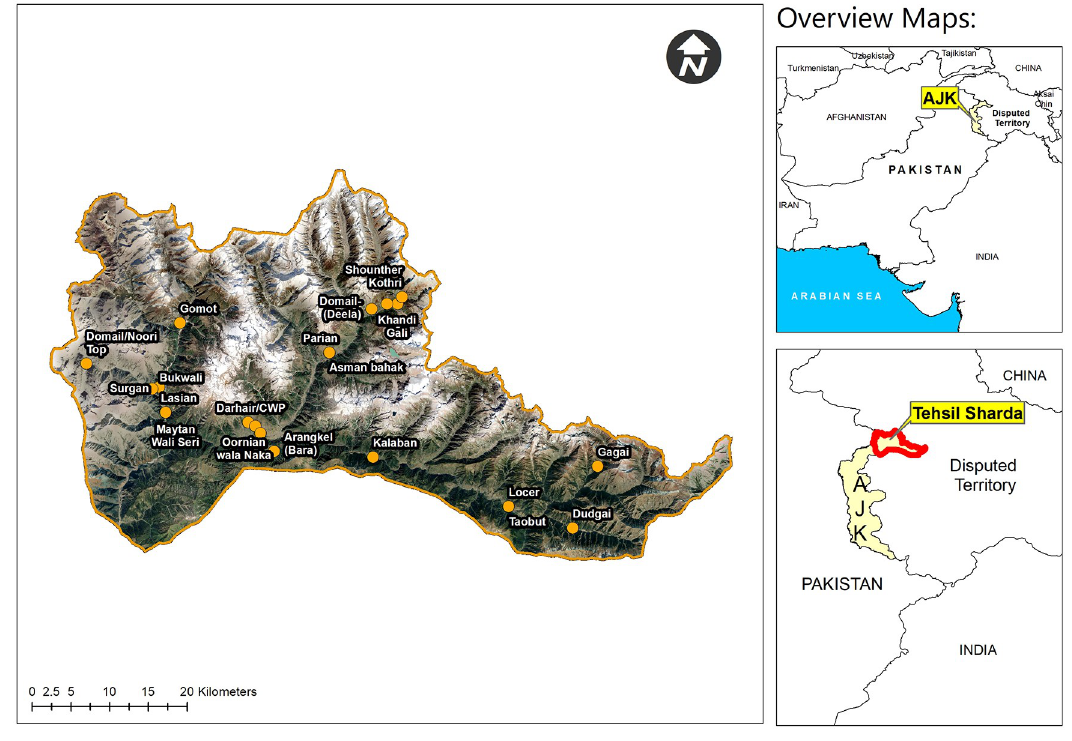
Fig 1. Map of the study